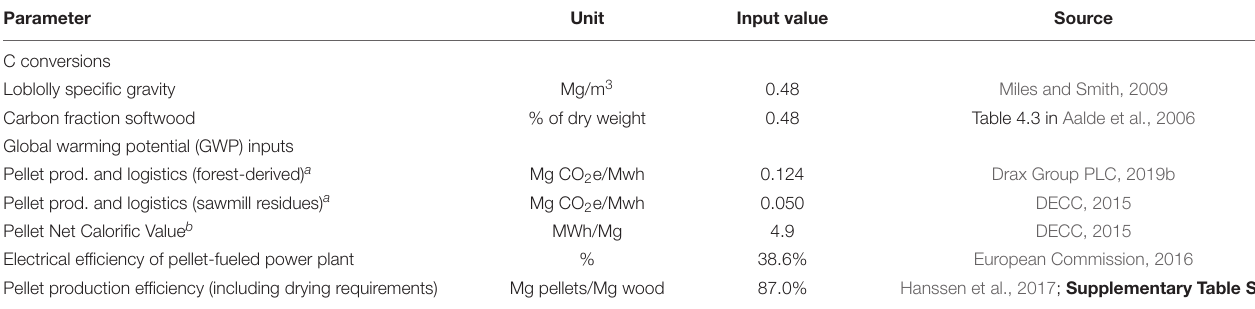
TABLE 1 | Key carbon LCA parameter for pellets produced at Drax mills in the southern US and consumed at Drax electricity plants in the UK.